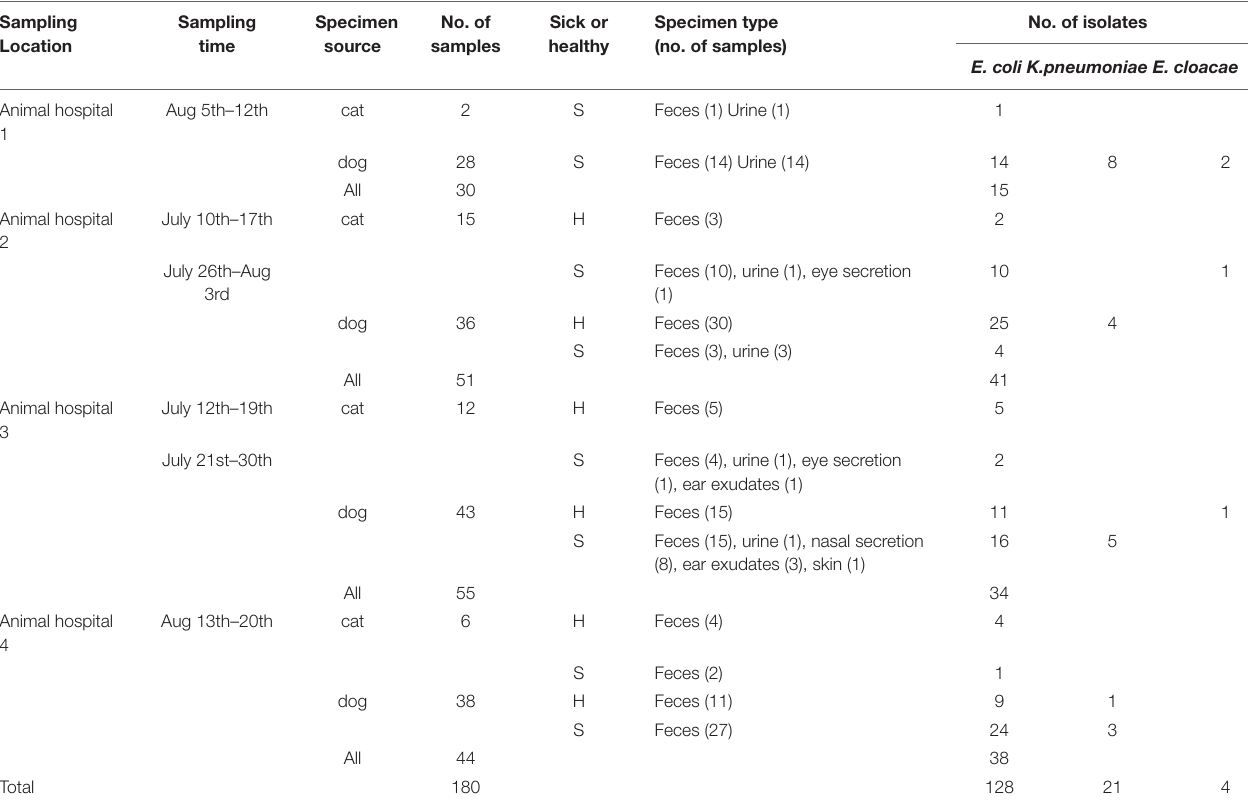
TABLE 1 | Source and origin of Enterobacteriaceae isolates obtained from companion animals in Guangzhou, China. Sampling